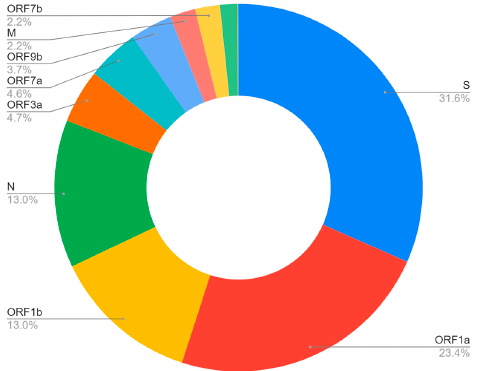
Figure 8. Percentage of mutation in each coding region.